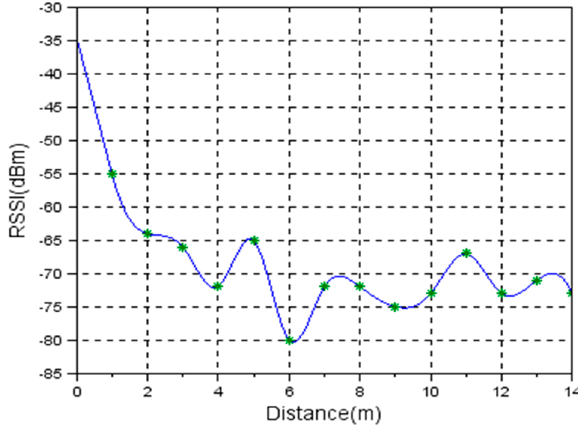
Figure 16. RSSI level vs. Distance. Indoor measurements on a 14 m long and 1.5 m wide corridor.